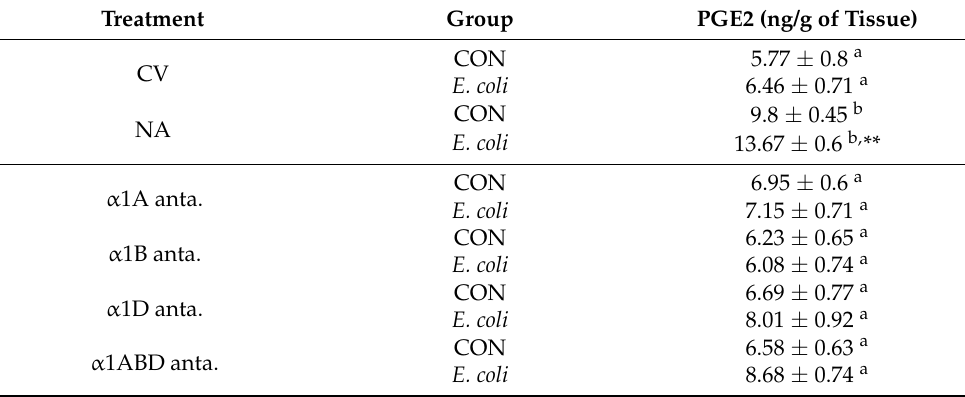
Table 2. Effects of noradrenaline (10 − 5 M) alone or antagonists of α 1-, α 2- and β -ARs (10 − 4 M) alone on the PGE2 secretion from the pig endometrium of the CON and E. coli groups, estimated by ELISA. Treatments were performed in triplicate for each of the five gilts in the individual groups. Results are expressed as the mean ± sem. Noradrenaline: NA; antagonist: anta.; control value: CV (untreated